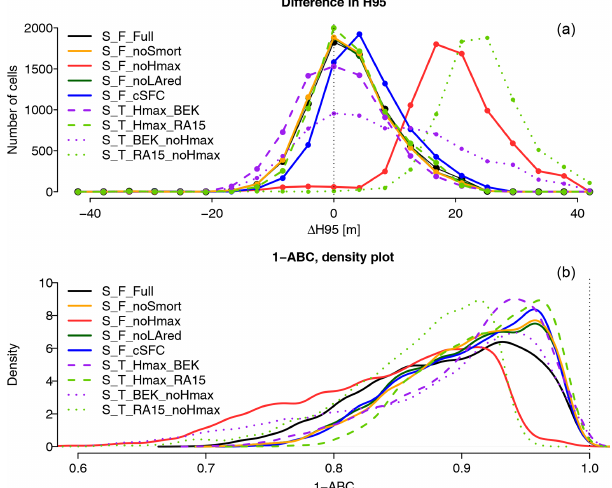
Figure 7. Distribution of the two goodness-of-fit metrics for canopy structure described in Sect. 2.2.3 over all forested cells of the sim- ulation domain ( n = 7138). Graph (a) shows the distribution of (cid:49) H95 (difference between H95 for simulated and observed data) for the different model configurations listed in Table 1. More values closer to 0 indicate a better agreement between observed and simu- lated canopy structure. As H95 uses the height classes of TreeMig, the results are given as discrete values with an interval of 4.2m. Graph (b) shows the density distribution of the 1 − ABC scores (bandwidth = 0 . 0075). The better the agreement between observed and simulated canopy structure, the more values are close to 1.